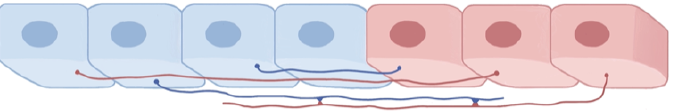
Figure 2. Cytonemes mechanosensing. Outline of the cytoneme–cytoneme or cytoneme–membrane interactions of the adjacent cells, which are assumed to be spatially consistent with the mechanical transmissions due to growth and internal regulation of